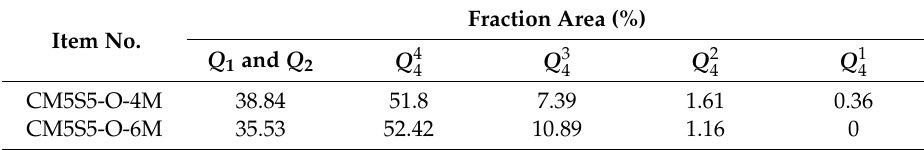
Table 7. E ff ect of recycled aggregate on the fresh properties of marble-based geopolymer concrete. Item